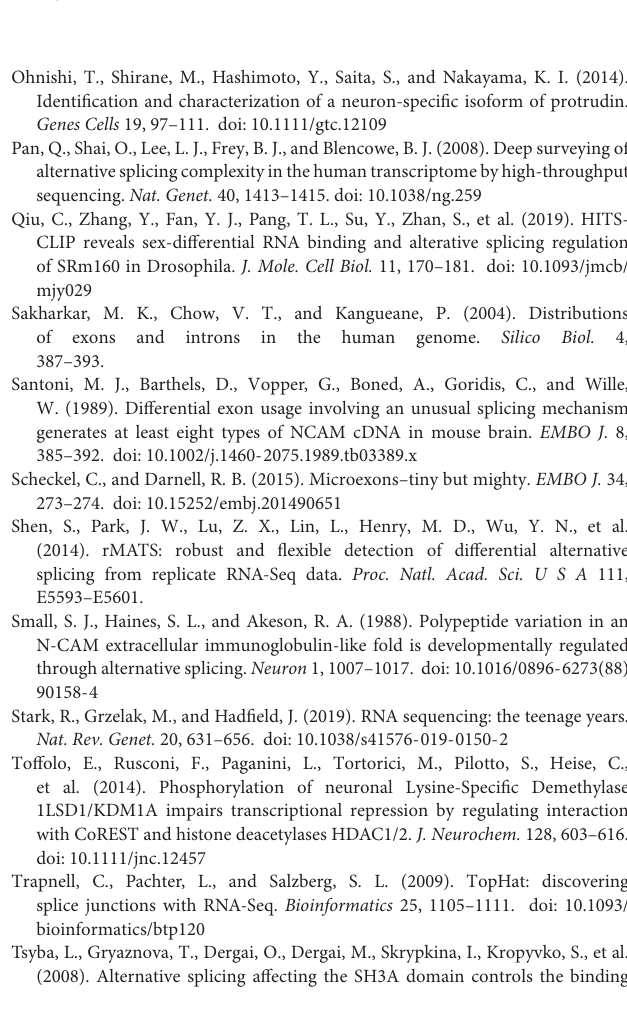
Supplementary Figure 4 | Analyses of alternatively spliced microexons in Drosophila . Supplementary Figure 5 | Distribution and GO analysis of sexually AS microexons. Supplementary Figure 6 | Length distribution of exons in human, mouse, zebrafish, and fruit fly. Supplementary Figure 7 | The evolutionary analysis of BTB domain-containing orthologs of the Drosophila fruitless gene. Supplementary Table 1 | Primers used in this study. Supplementary Table 2 | Analyses of RNA-seq reads from fruit fly samples. Supplementary Table 3 | Remapping of unmapped-reads by ce-TopHat. Supplementary Table 4 | List of the identified reliable microexons in this study. Supplementary Table 5 | List of alternatively and constitutively spliced CDS microexons in Drosophila. Supplementary Table 6 | List of AS microexons that are specifically spliced and included in tissues. Supplementary Table 7 | List of significantly sexually AS microexons in